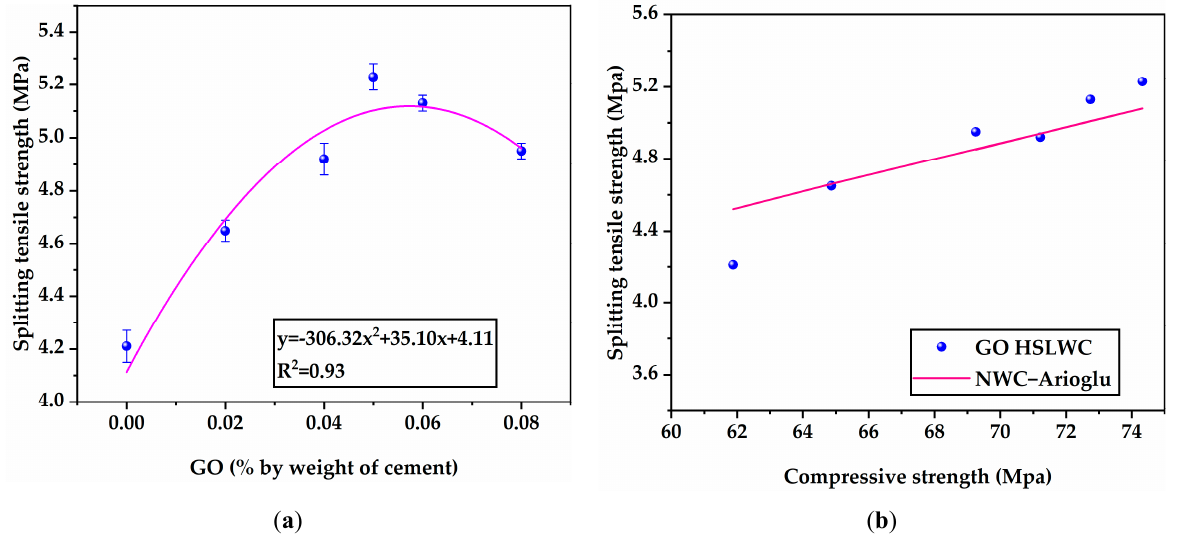
Figure 9. Spli tt ing tensile strength results of HSLWC: ( a ) spli tt ing tensile strength with di ff erent Figure 9. Splitting tensile strength results of HSLWC: ( a ) splitting tensile strength with different contents of GO; ( b ) prediction of spli tt ing tensile strength. contents of GO; ( b ) prediction of splitting tensile